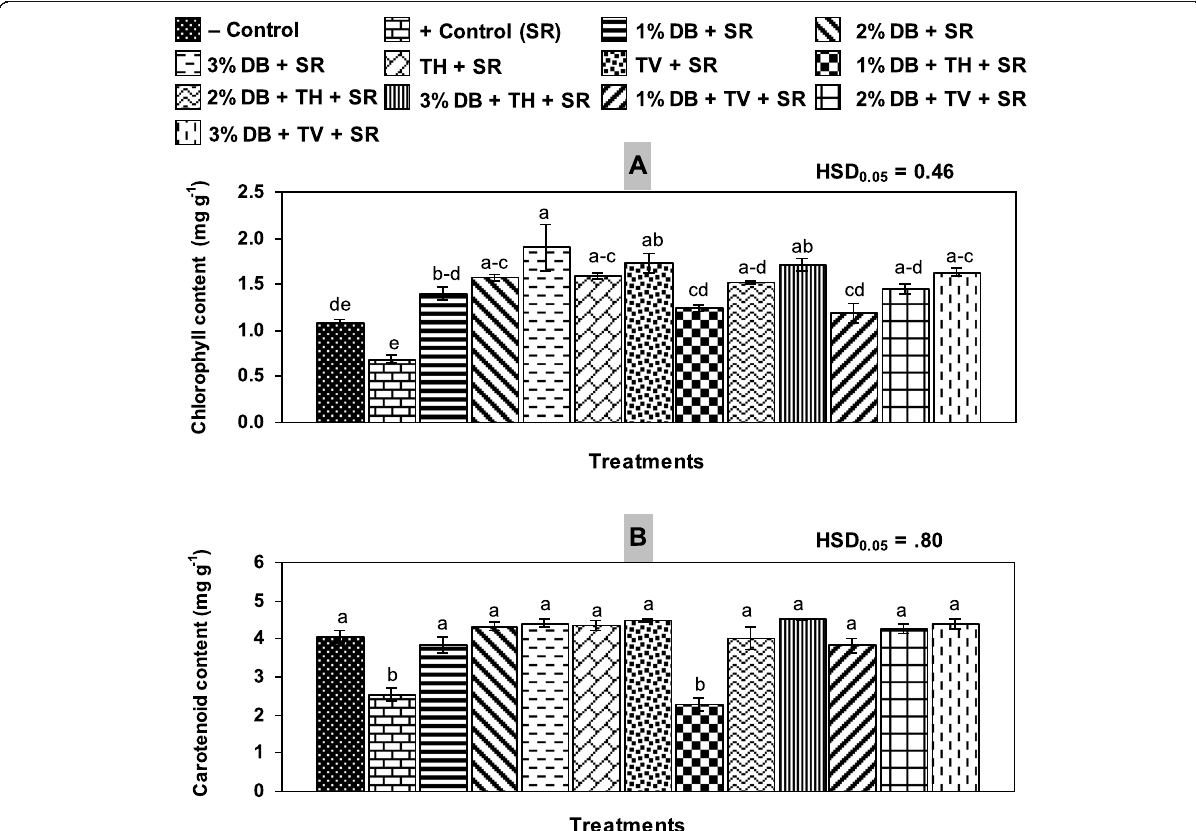
Fig. 2 Effect of Sclerotium rolfsii (SR), Trichoderma harzianum (TH), T. viride (TV), and dry biomass (DB) of Chenopodium album on leaf chlorophyll and carotenoid content of chickpea var. Noor 2009. Vertical bars show standard errors of means of five replicates. Values with different letters at their top show significant difference ( p ≤ 0.05) as determined by Tukey ’ s HSD